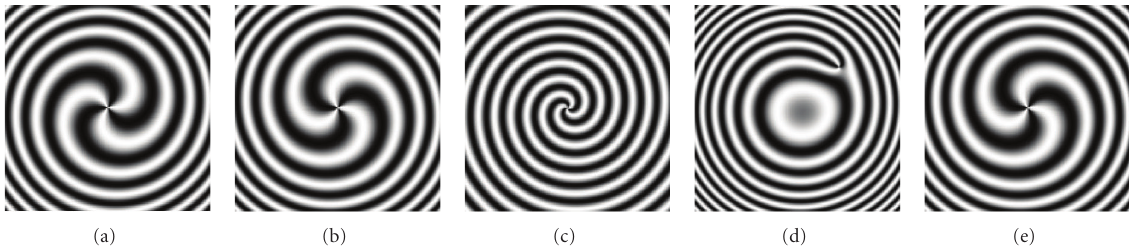
Figure 19: Fringes obtained due to interference between a vortex of charge 3 with (a) Spherical beam of positive curvature (b) spherical beam of negative curvature (c) conical beam. (d) Interference between an o ff centred vortex and a spherical wave (e) Interference between negatively charged vortex and a spherical beam with positive